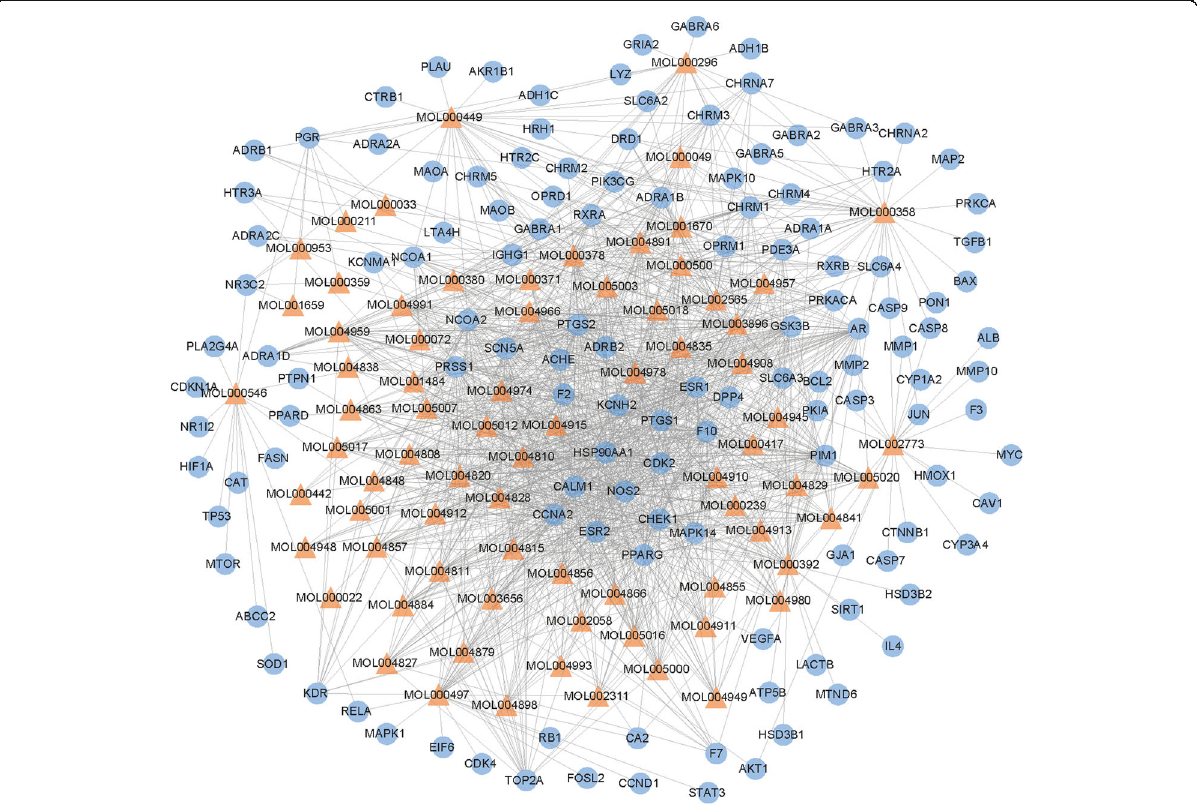
Fig. 2 A compound node and a protein node are linked if the protein is targeted by the corresponding compound. Node size is proportional to its